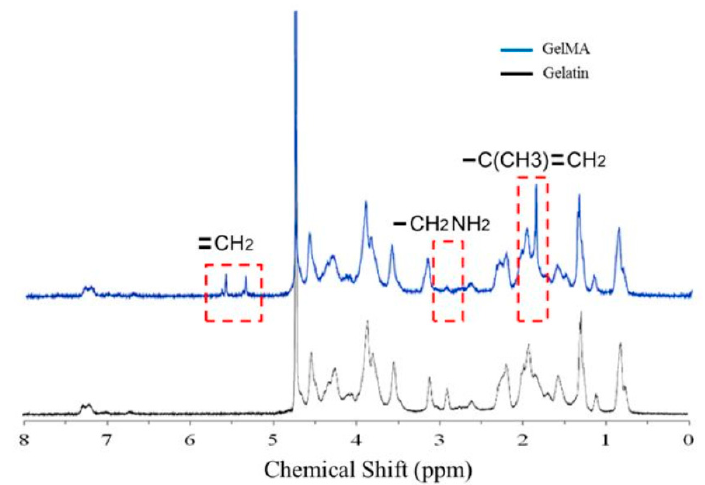
Figure 2. Here, 400-MHz 1 H NMR spectra for unsubstituted gelatin and GelMA are shown. The peaks due to the added methacrylate were between 5 and 6 ppm and between 1.5 and 2 ppm. The peaks due to the lysine methylene from gelatin were between 2.5 and 3 ppm.